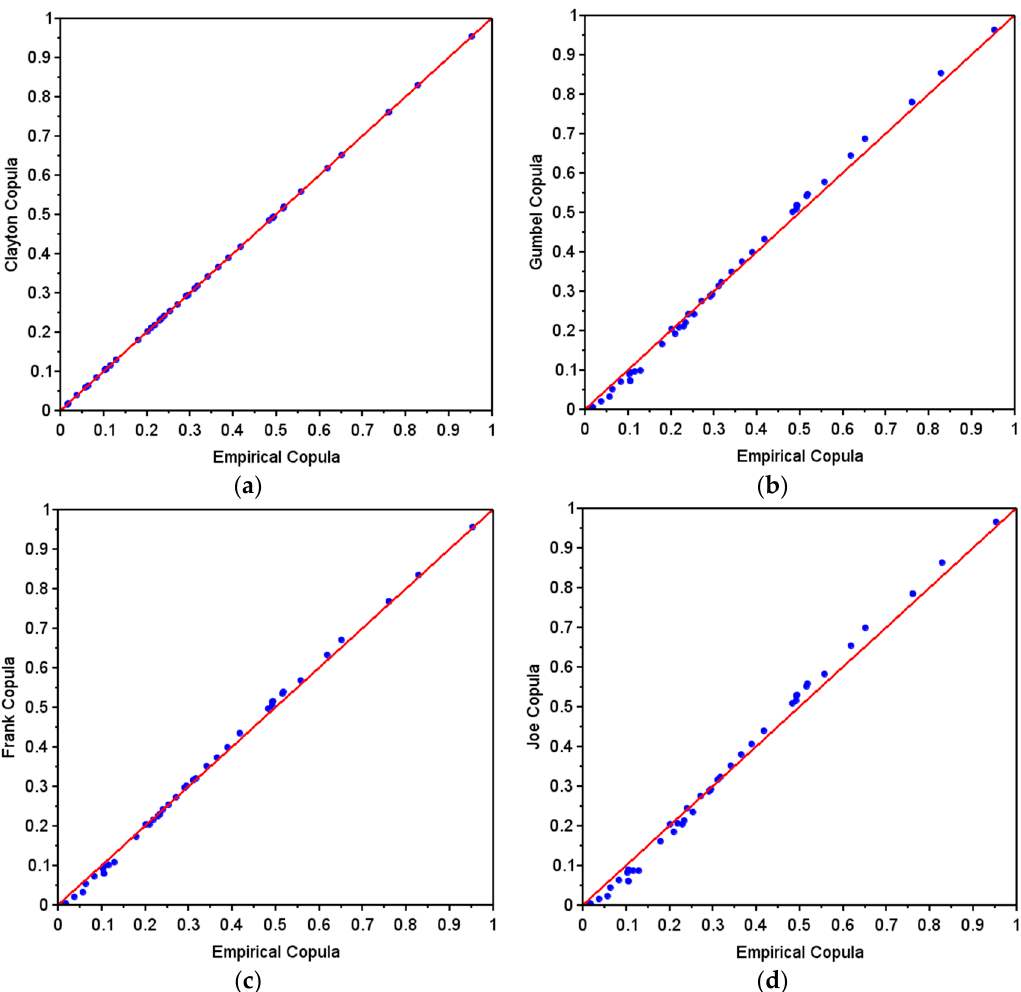
Figure 2. PP Plots of Clayton ( a ), Gumbel ( b ), Frank ( c ), and Joe ( d ) copulas.